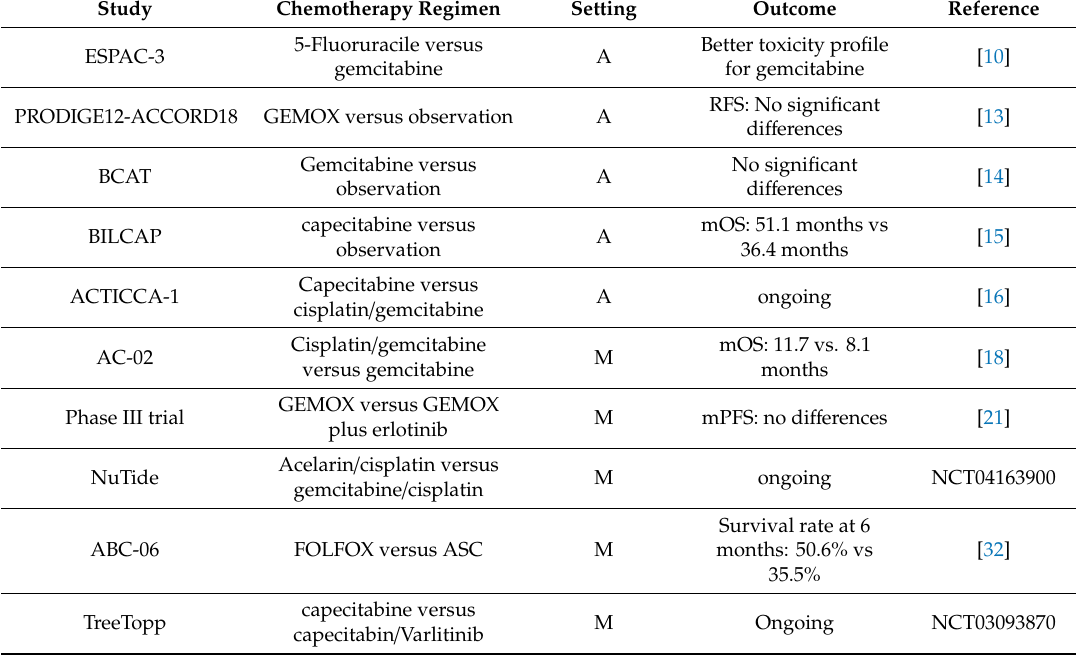
Table 1. Summary of significant phase-III studies regarding chemotherapy for cholangiocarcinoma, in an adjuvant setting (A) and metastatic disease (M).